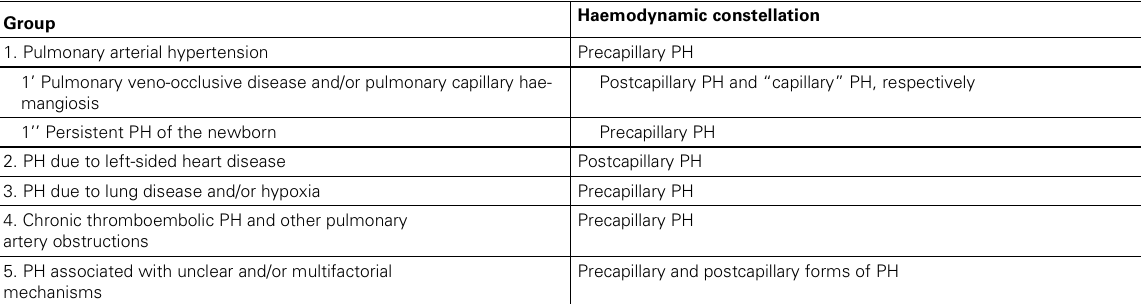
Table 1: Classification of pulmonary hypertension (PH) according to current guidelines [1]. Please see table 2, table 4 and text for details.